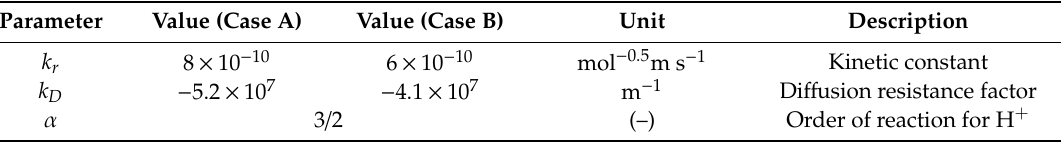
Table 2. Parameters used in the simulation results.